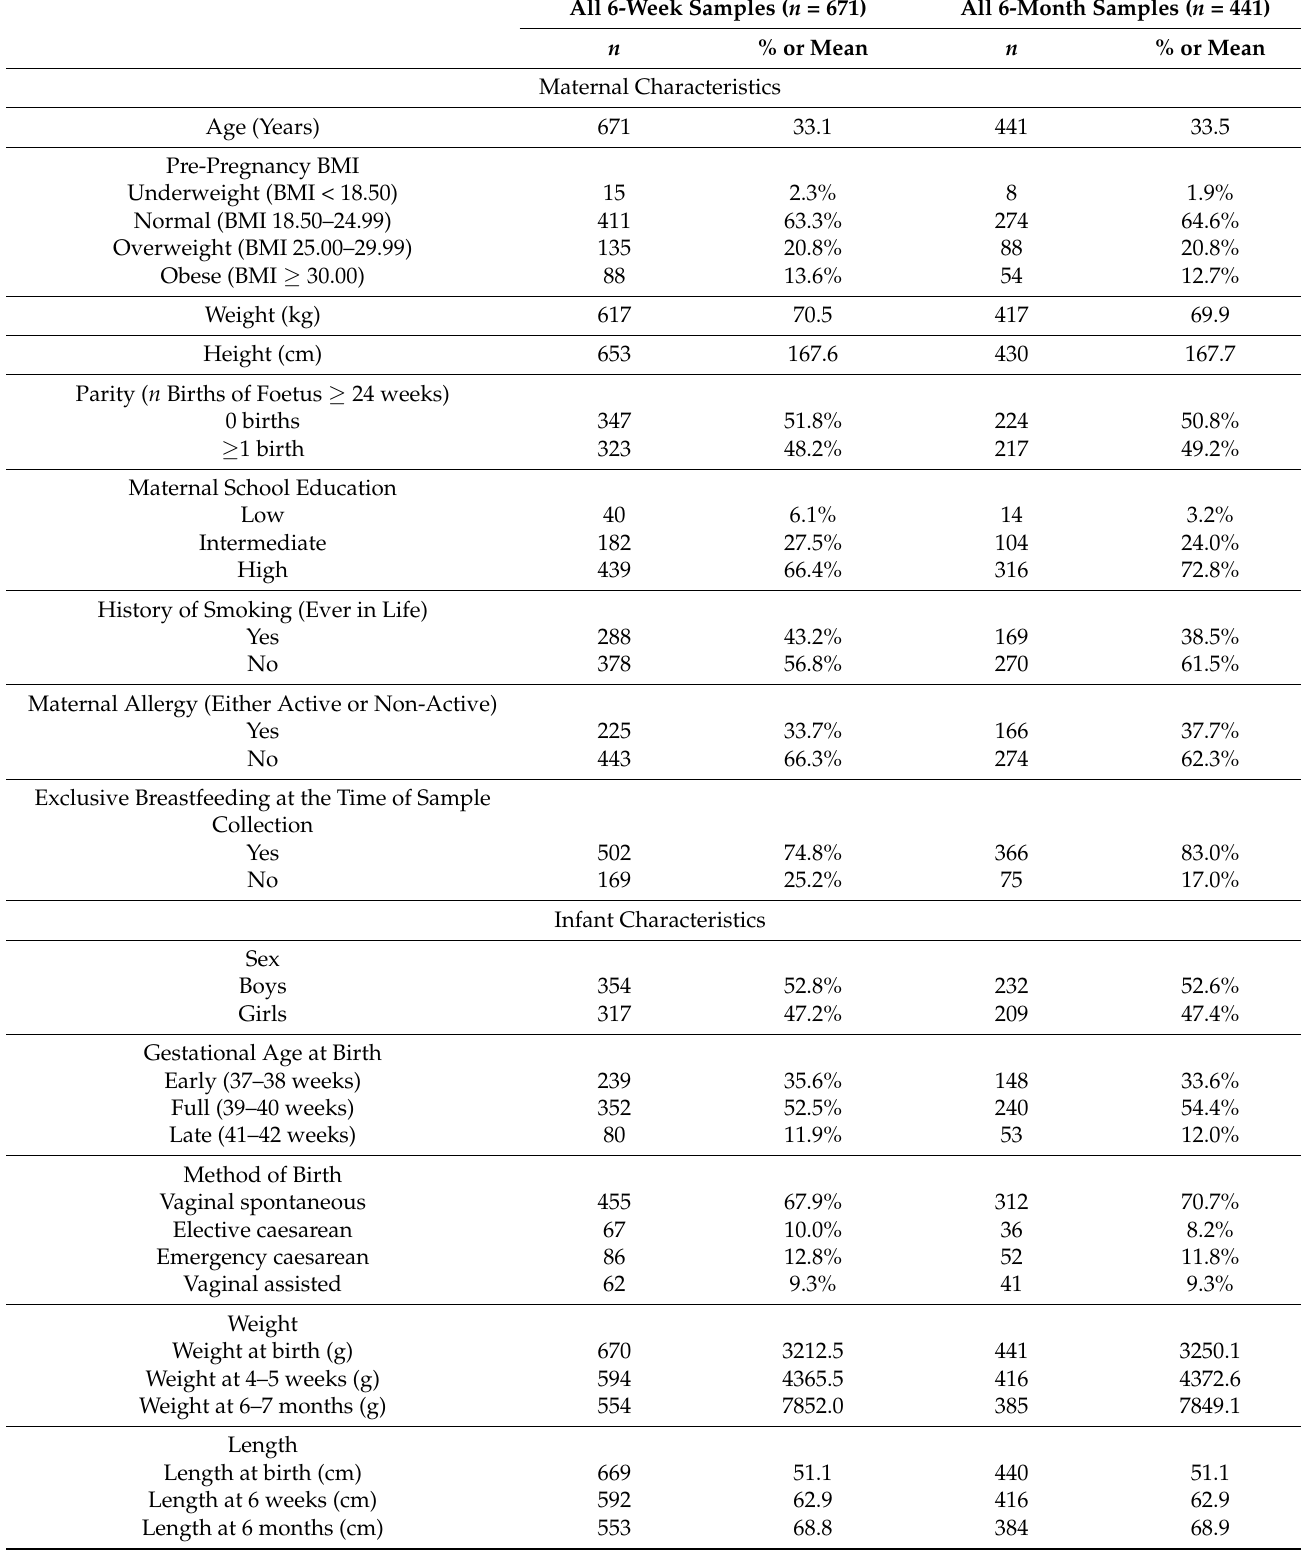
Table 1. Characteristics of the lactating women who had amino acid data available at 6 weeks and 6 months of lactation and their infants in the Ulm SPATZ Health